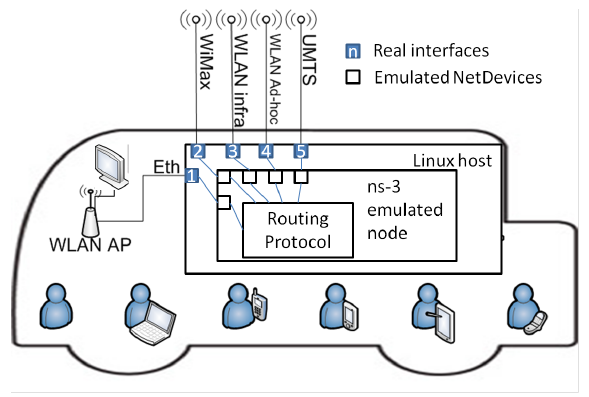
Figure 5: Elements present in each bus of the Ve- hicular network testbed